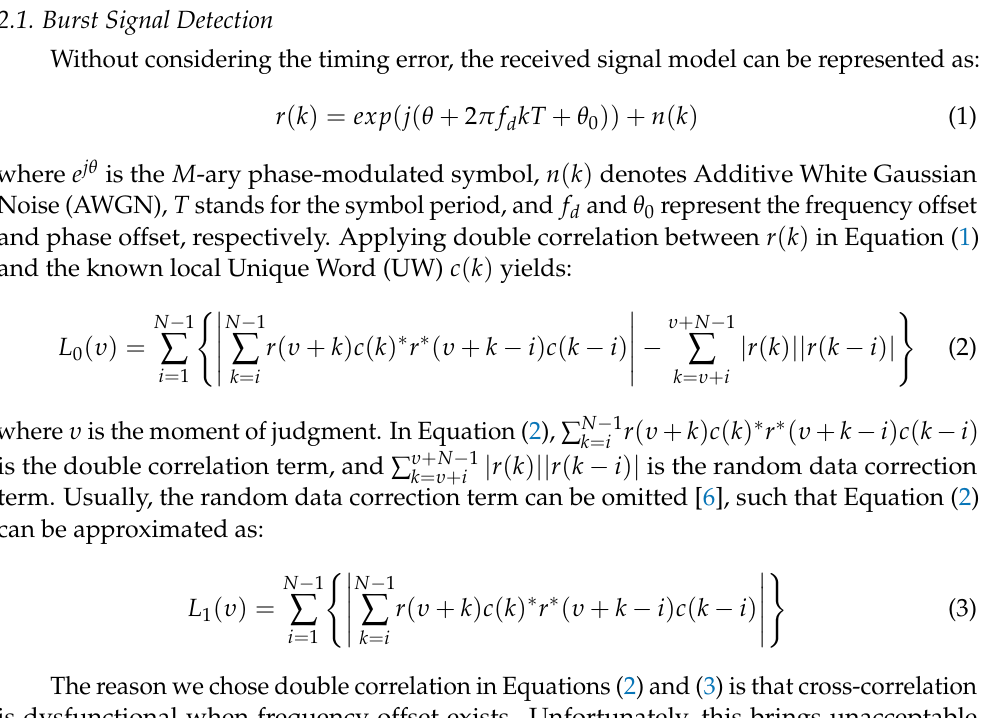
Figure 1. Algorithm